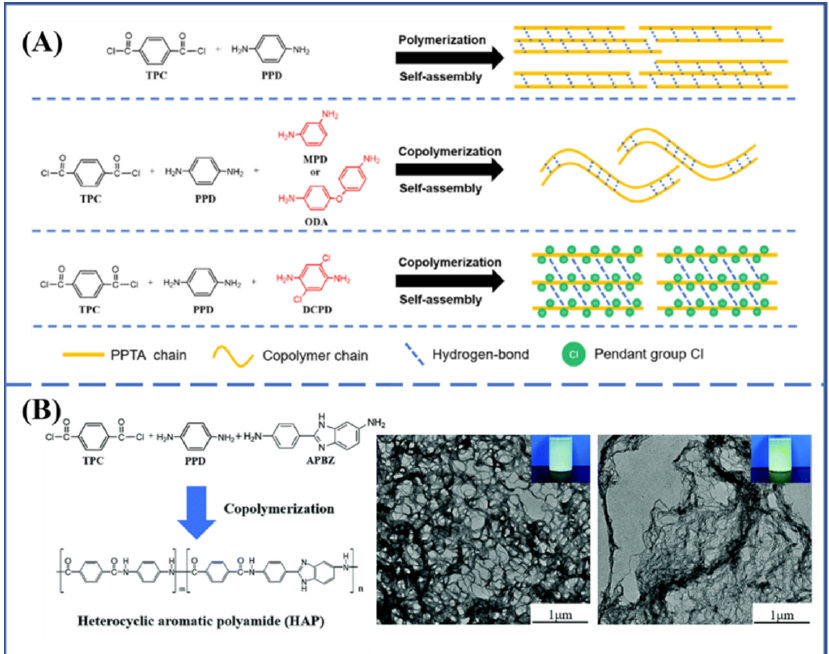
Figure 7. ( A ) Schematic self-assembly of copolymerized aramid nanofiber [44]. Copyright 2020 John Wiley and Sons (Hoboken, NJ, USA). ( B ) The synthesis of a heterocyclic aramid and the morphology of the heterocyclic aramid nanofiber [45].